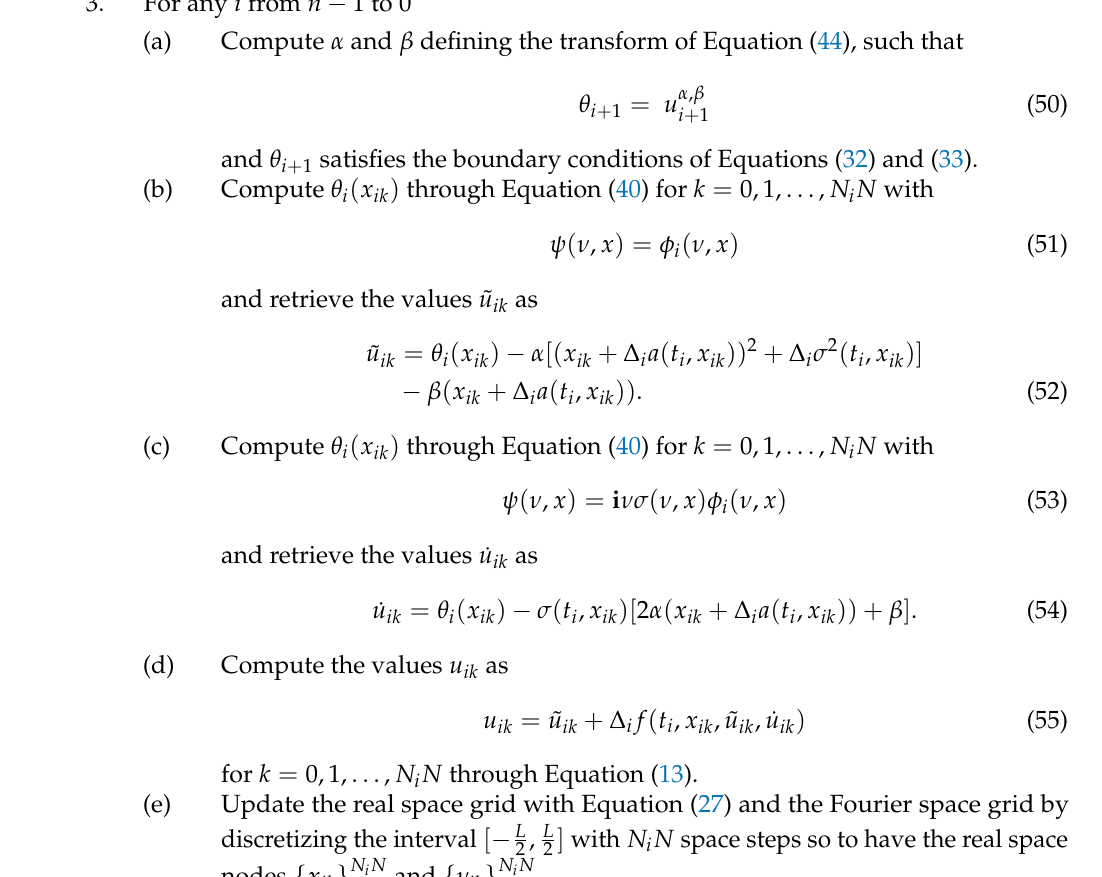
Algorithm 1 Fourier Interpolation Method on Alternative Grid